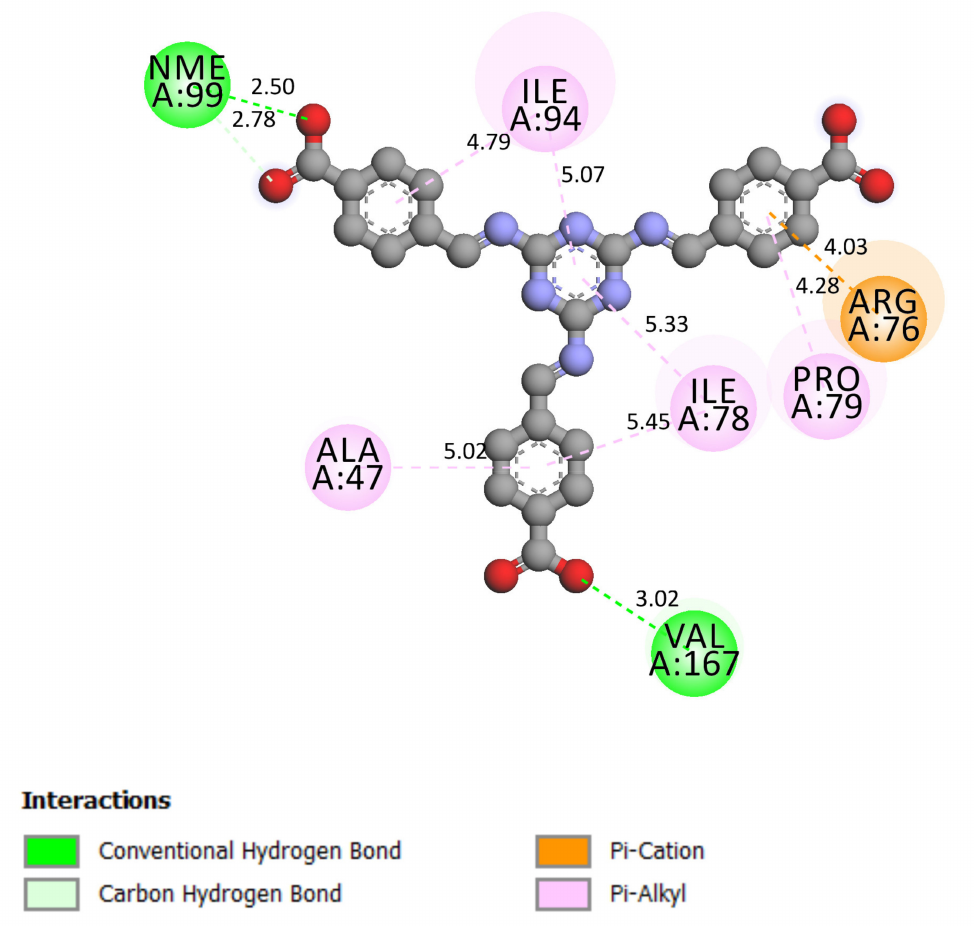
Figure 4. 2D interaction of MT with the amino acid residues of E. coli DNA gyrase